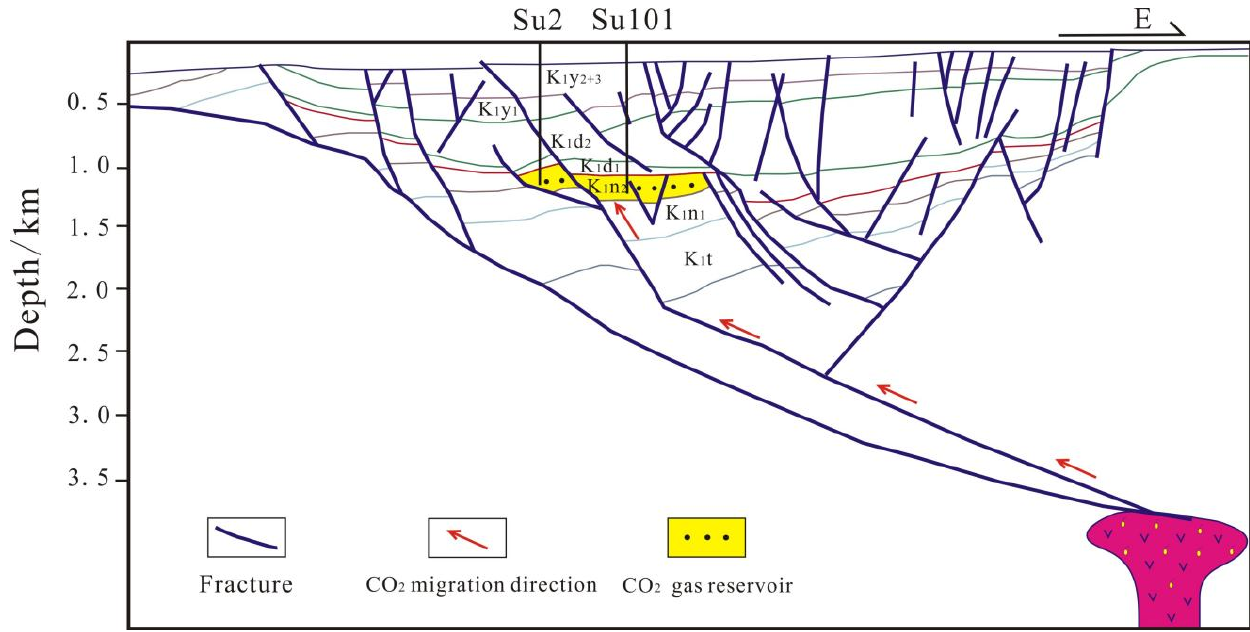
Figure 8. Forming mode of CO 2 reservoir in Wuerxun depression of Hailar